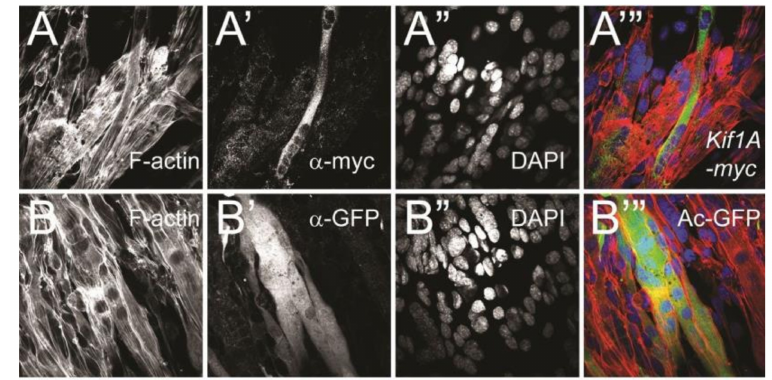
Figure 7. Kif1A overexpression a ff ects muscle maturation: Twenty-four hours after transfection (with Kif1A-myc or AcGFP), C2C12 myoblast cells were switched to di ff erentiation medium for 36 h and then fixed and stained. ( A–A”’ ) Kif1A transfected cells. ( B–B” ) GFP-transfected cells. ( A , B ) Phalloidin staining reveals F-actin organization in all cells. ( A’ ) Anti-myc staining to detect Kif1A expressing cells and ( B’ ) anti-GFP staining to detect GFP-transfected control cells. ( A” , B” ) DAPI nuclear staining. ( A”’ , B”’ ) Merged images: note that di ff erentiated C2C12 cells with Kif1A overexpression ( A , C–C’” ) formed a syncytium but contained scant